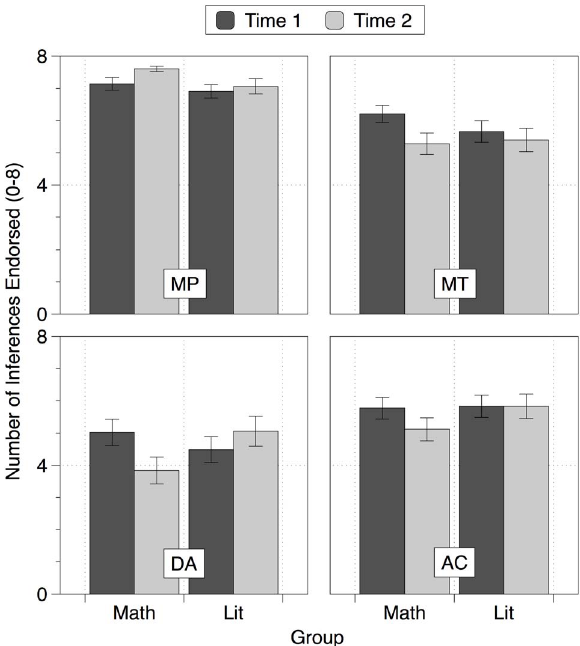
Figure 3. The number of inferences endorsed by each group, for MP, MT, DA and AC inferences at the two time points. Error bars show 6 1 SE of the mean.